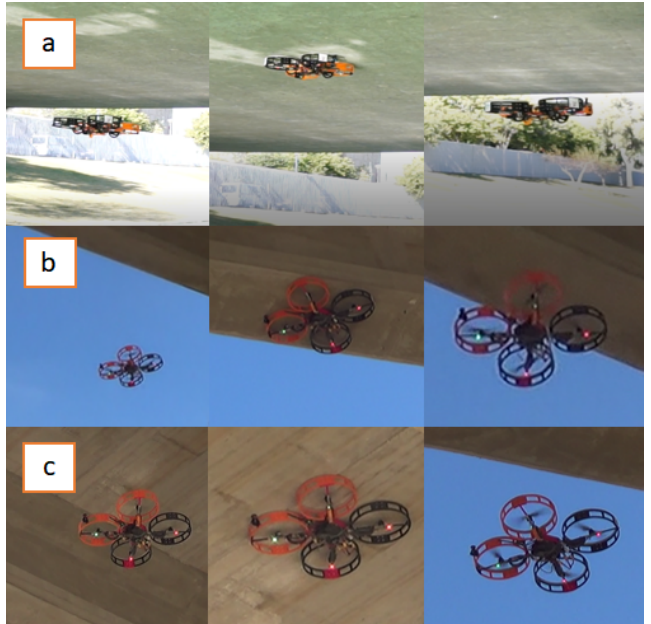
Figure 11. Sequences of the inspection by contact applications in three different kind of bridge. ( a ) Application for the Cartuja bridge (flat surface), ( b ) application for the Grazalema